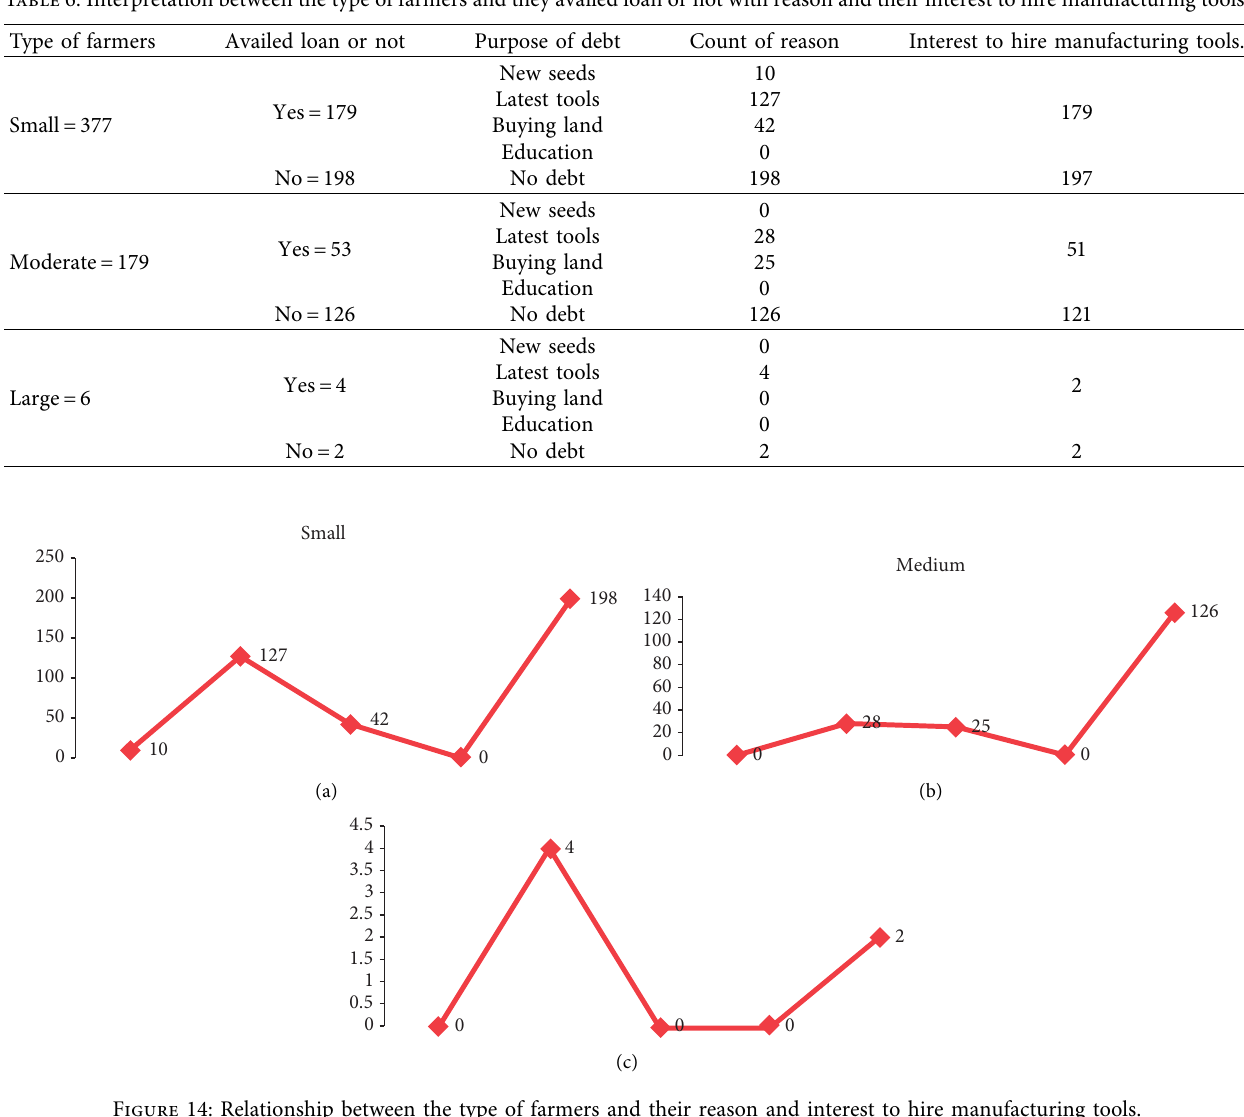
Figure 14: Relationship between the type of farmers and their reason and interest to hire manufacturing tools.